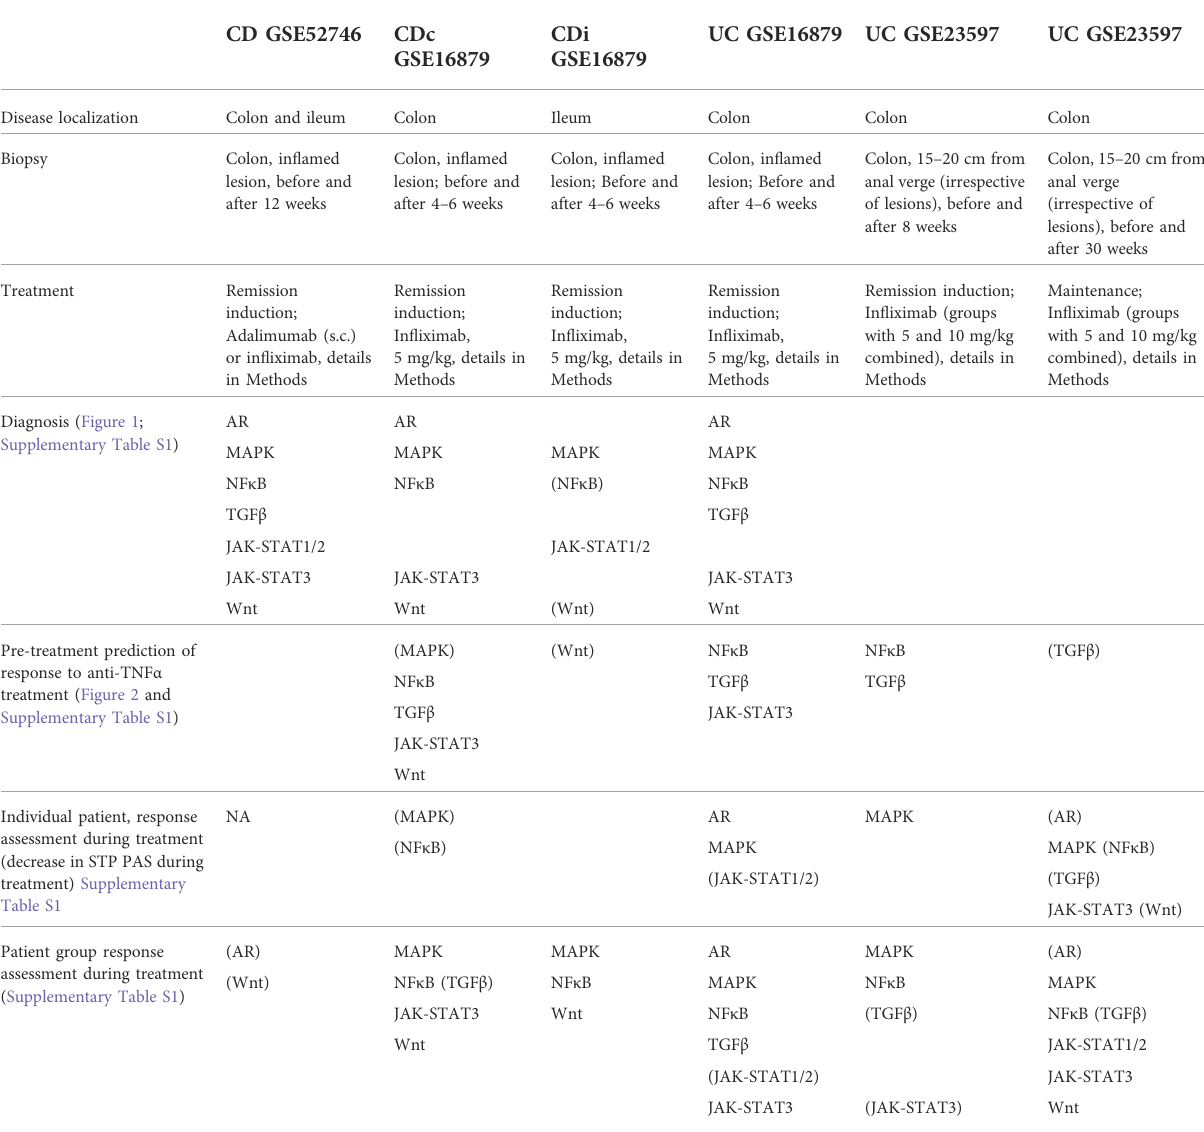
TABLE 1 Abnormal STP activity in patients with various forms of IBD (diagnosis), and in responder versus non-responder patients, pre-treatment and during treatment. Diagnosis: Comparison between IBD and healthy control STP activity; indicated STPs have higher PAS in IBD group. Pre- treatment prediction of response to anti-TNF α treatment: comparison between pre-treatment STP activity of responder versus non-responder groups; indicated STPs have higher PAS in responder patient group. Individual patient response assessment during treatment: comparison between delta (for individual patients) in STP activity before - during treatment of responder versus delta in non-responder groups; indicated STPs have higherdeltaPASinresponderpatients.Patientgroupresponseassessmentduringtreatment:Comparisonpatientresponderwithnon-responder groupsduringtreatment;indicatedSTPshavehigherPASinrespondergroupduringtreatment.IndicatedSTPsinthetable:STPswithsigni fi cantly higher PAS ( p < 0.01); between brackets: STPs with marginal signi fi cance ( p < 0.05). See Supplementary Table S1 for absolute p -values. For speci fi cs of patient inclusion, dosing and sample type, see Methods for description of datasets. NA: Not